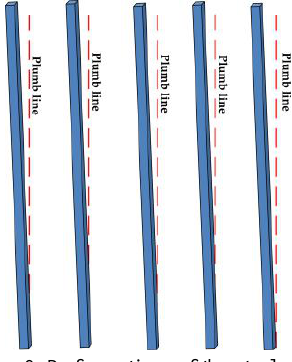
Figure 9: Deformations οf the steel